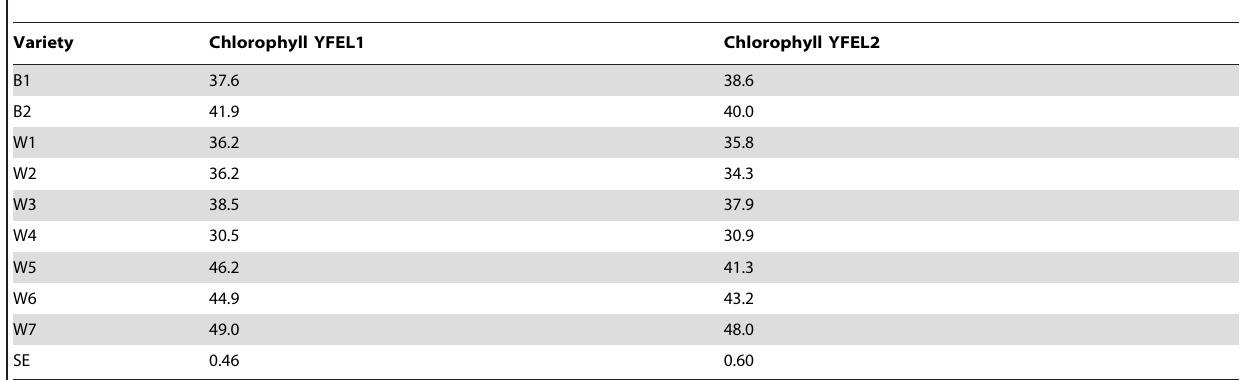
Table 3. Predicted means and SE for the chlorophyll content of YEFL1 and YEFL2.